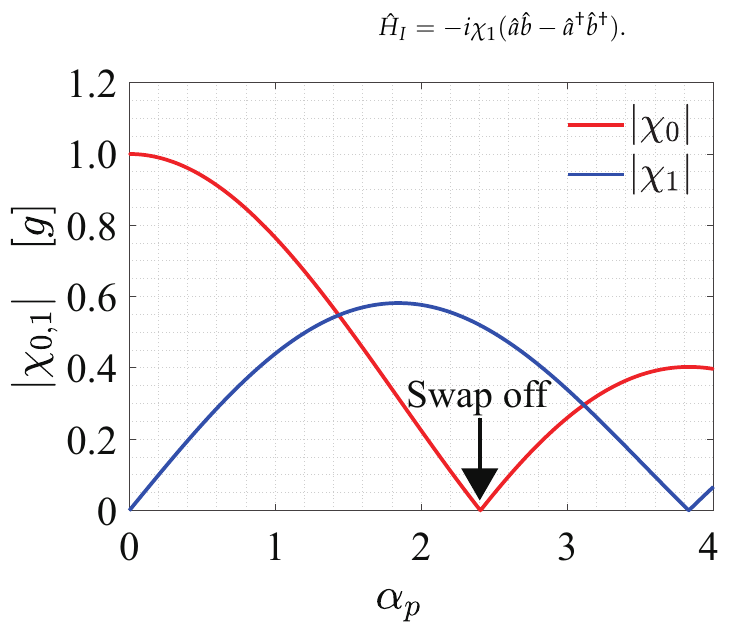
Figure 3. Dependence of the Bessel function of the first kind of order 0 (red) and 1 (blue) on the dimensionless parameter α p of the pump field, which determines the strength of χ 0,1 , where α p = 2.404 is chosen to eliminate the swap interaction between the two